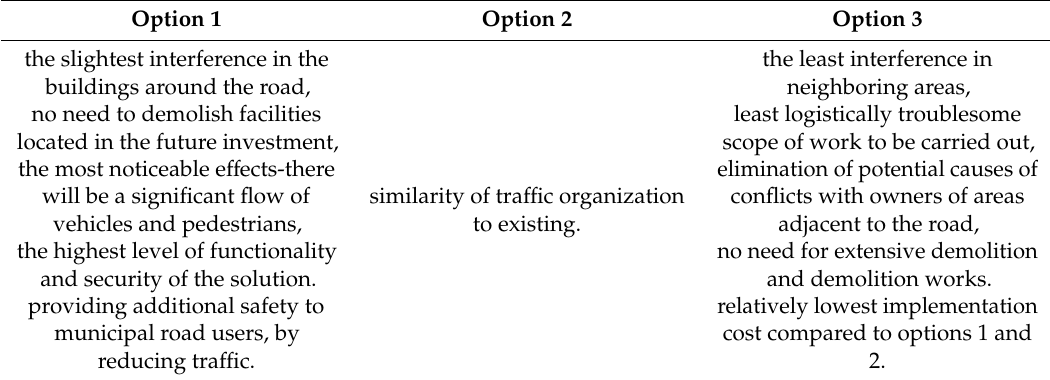
Table 3. Advantages of options 1, 2, 3.